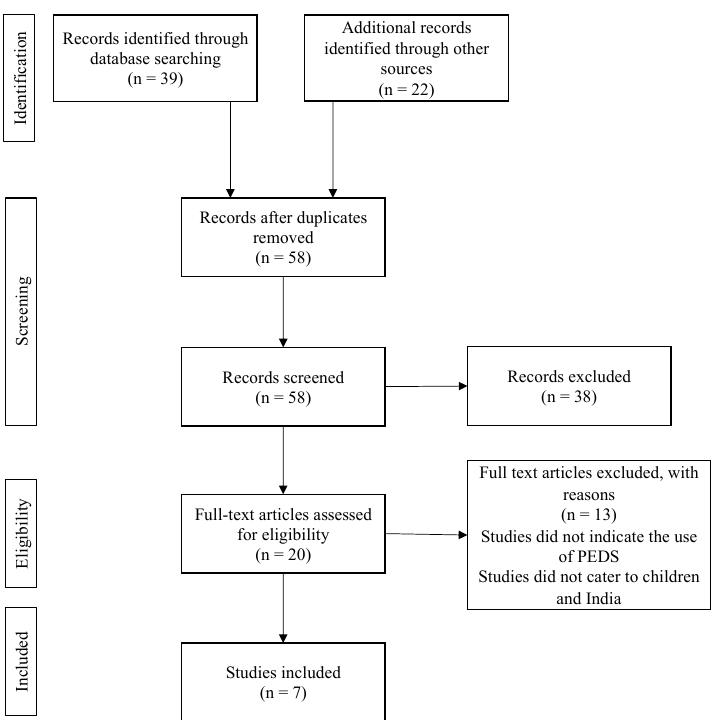
Figure 1. PRISMA diagram of studies included in the comprehensive scoping review for the PEDS.